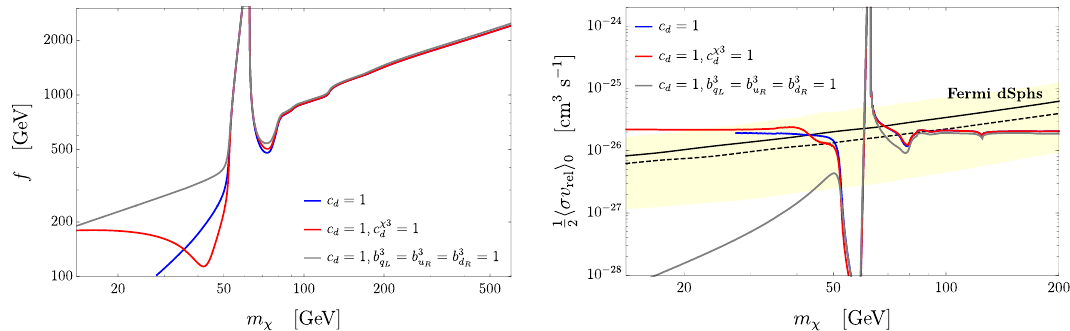
Figure 3: Left: contours obtained requiring that the thermal relic density of χ matches the observed one, assuming the given values of the EFT coefficients and setting the others to zero. Right: the present-day annihilation cross section to SM particles, calculated along the relic density contours shown in the left panel. The black line (yellow band) is the 95% CL observed upper limit (95% CL uncertainty band on the expected limit) from the dSphs analysis in Ref. [ 60 ] . The dashed black line corresponds to the observed limit from the analysis of a smaller dSphs sam- ple [ 61 ] . The quoted experimental bounds assume annihilation to b ¯ b